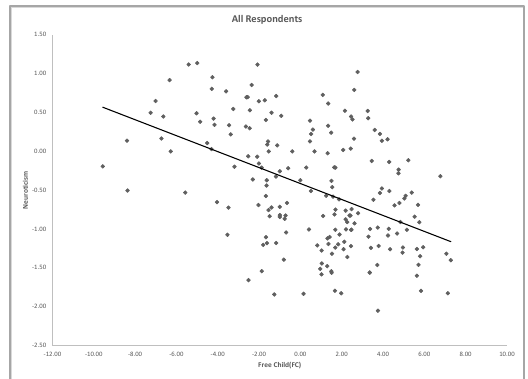
Figure 3. Moderately negative r between Adult (A) and Neuroticism.